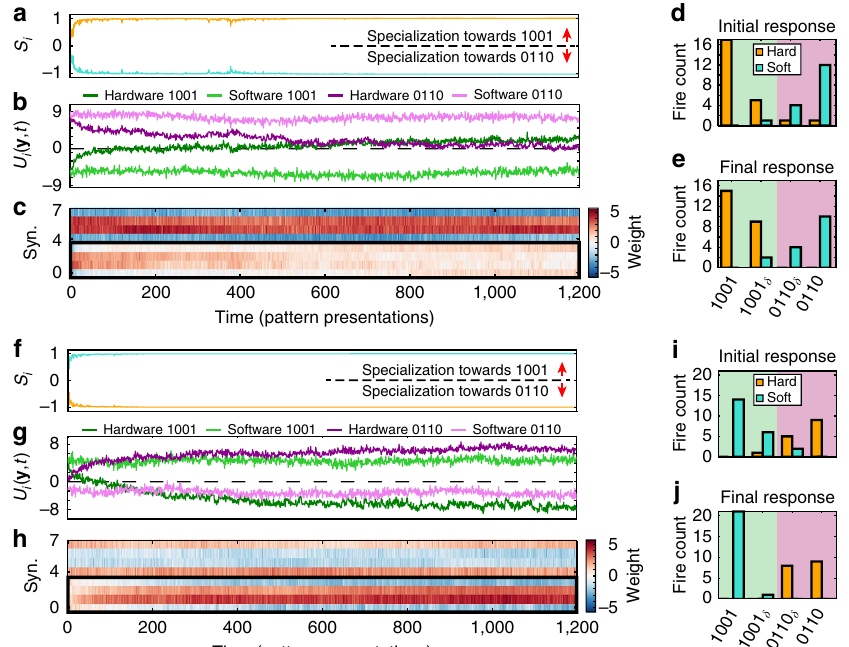
Figure 4 | Reversible learning is supported in WTA networks using TiO 2 memristor-based synapses. ( a – e ) First run attempting to unteach the pattern recognition abilities gained in Fig. 3. ( a ) Evolution of neuron specializations S i to patterns 0110 and 1001 as weights change over successive events, illustrating the interplay between the two neurons. ( b ) Computed membrane potentials of each neuron to both prototype patterns according to their weights at every trial illustrating the intrinsic pattern preferences of each neuron, that is independent of their interaction in the WTA network. ( c ) Evolution of hardware (synapses 0–3, enclosed in thick, black frame) and software (synapses 4–7) weights. ( d , e ) Responses of the WTA network to the initial ( d ) and final ( e ) 41 input samples. The fire count of both the hardware synapse neuron (orange) and the software synapse neuron (turquoise) is shown for patterns 0110, 1001 and patterns that differ from these prototypes in one position (0110 d and 1001 d ). ( f – j ) Corresponding data as in a – e for second run attempting to reteach the memristor synapses to prefer pattern 0110. The abrupt changes between final and initial responses over consecutive experiments mainly arise from the different initializations of the software synapses in each